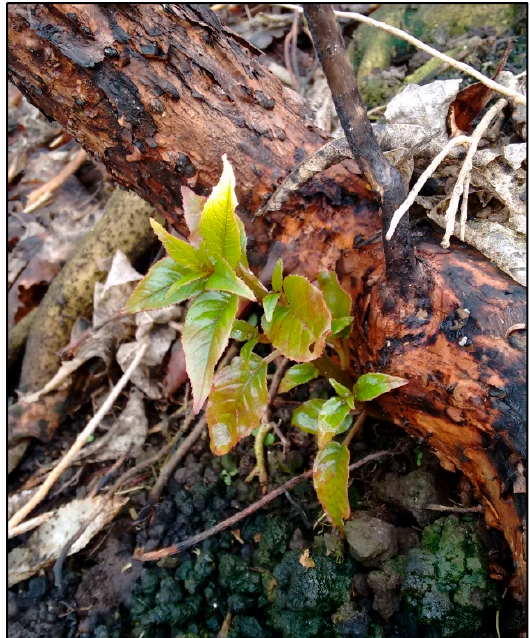
Figure B2. Fuchsia excorticata resprouting. Figure B3. Coprosma robusta/lucida Figure A2. Fuchsia excorticata resprouting.